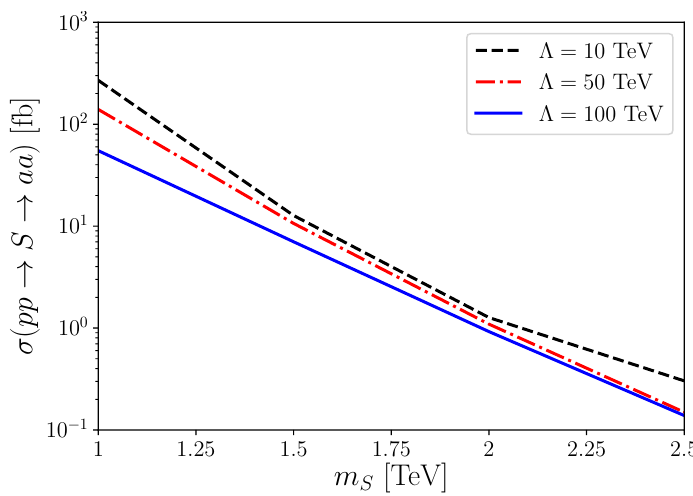
Figure 3 . The resonant production cross section of two ALPs as a function of the S mass for three (cid:12)xed values of (cid:3). We (cid:12)xed m a = 0 : 1 GeV, f S = 100 GeV, and c BB = c WW = c GG = 1. (cid:3) = 10 TeV. For m = 1 TeV (cid:12)xed, BR ( S ! aa ) drops from nearly 100% for (cid:3) = 100 S